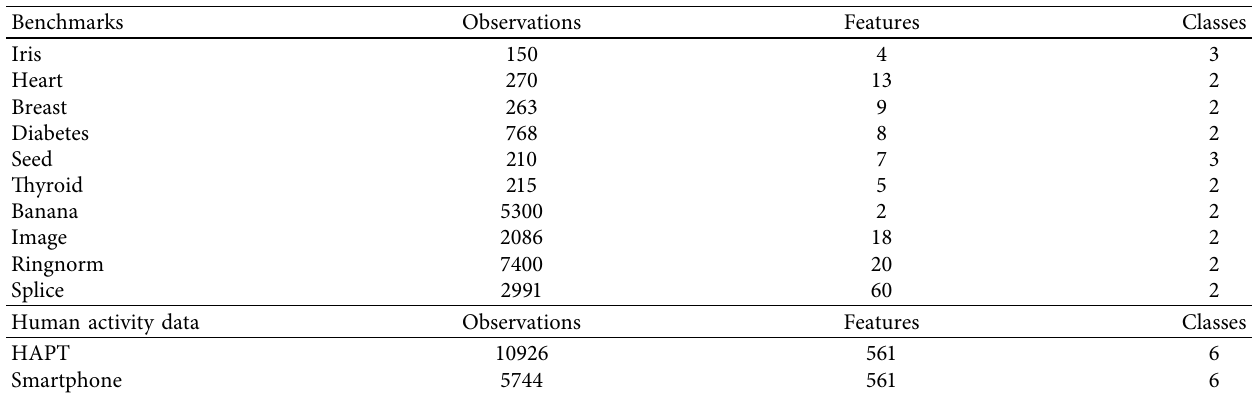
Figure 2: The type of classes for human activity in Smartphone data. Table 1: Details of